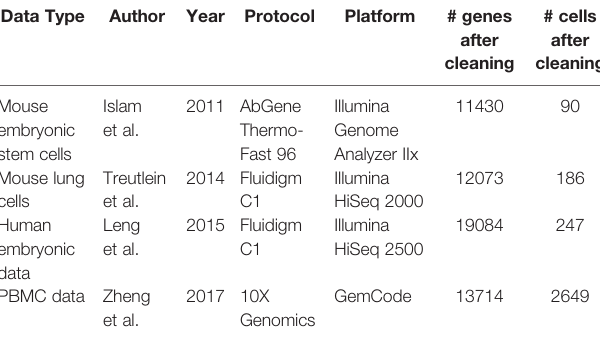
TABLE 1 | Summary of data sets used in this